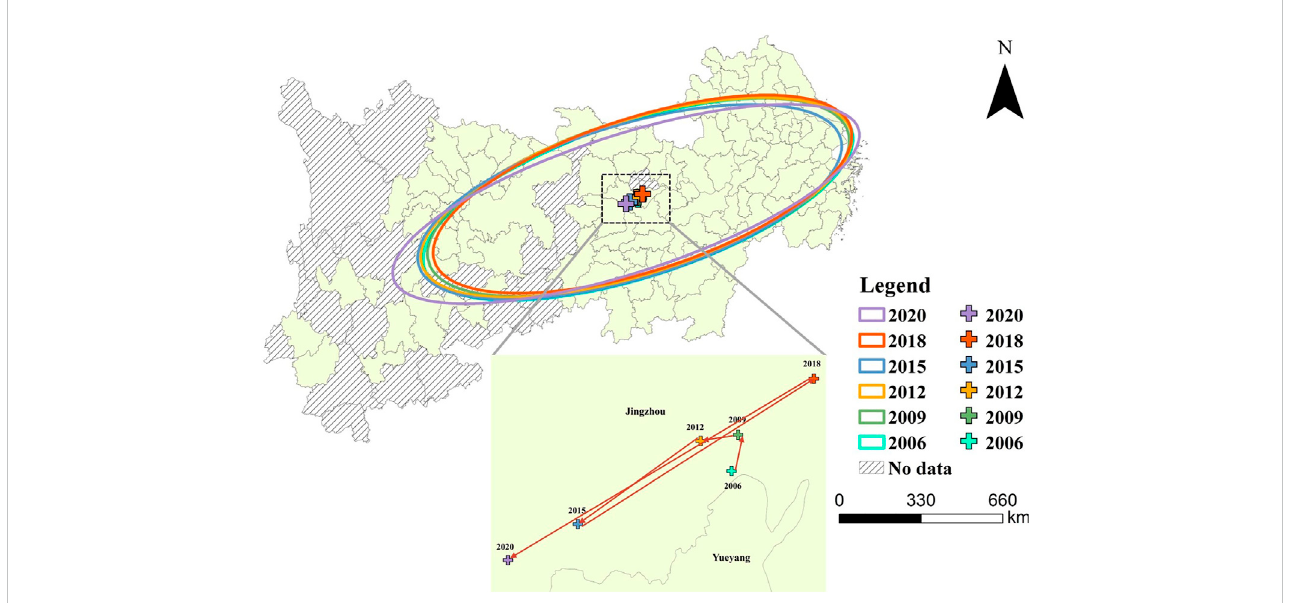
FIGURE 7 Diagram of standard deviation ellipse and center of gravity trajectory of ULUE in the